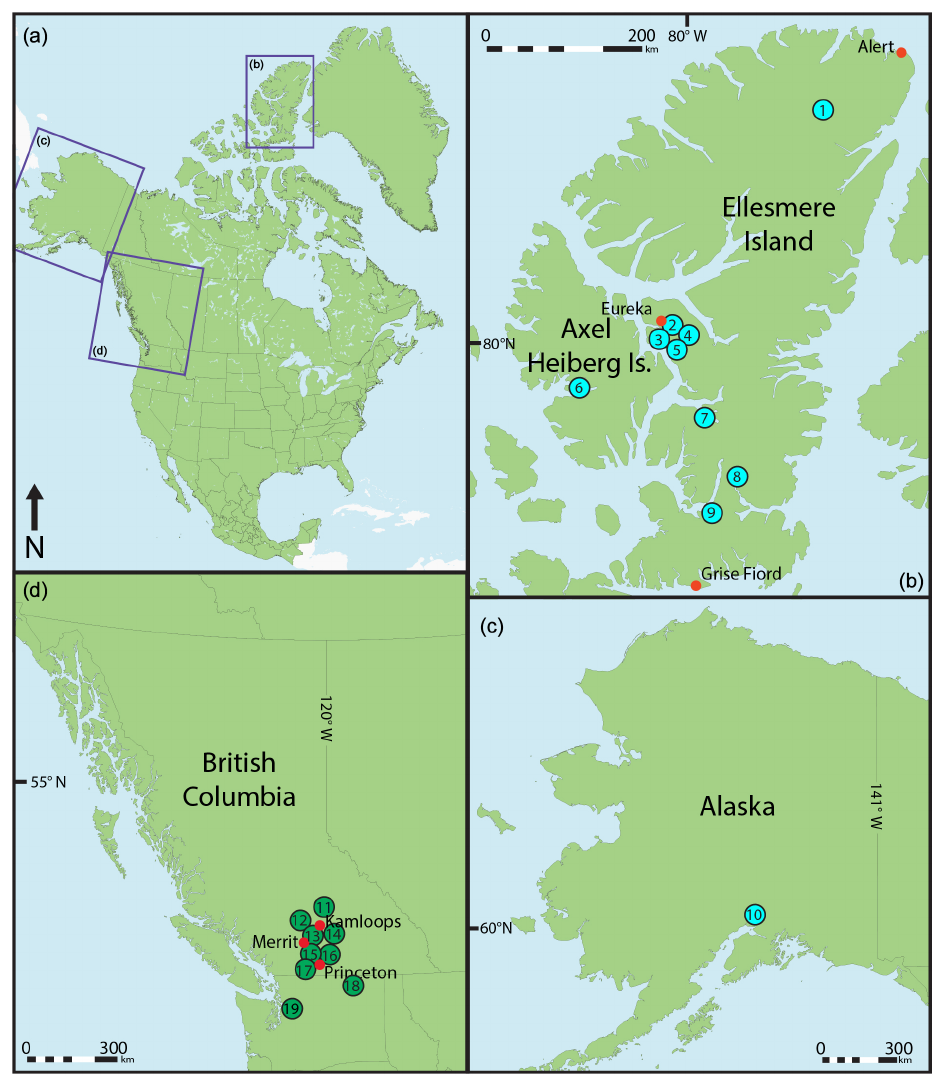
Figure 1. Map showing the location of the fossil localities used in this study. (1) Lake Hazen, (2) Mosquito Creek, (3) Ox-Head Creek, (4) Hot Weather Creek, (5) Fosheim Anticline, (6) Strand Fiord), (7) Strathcona Fiord, (8) Split Lake, (9) Stenkul Fiord, (10) Evan Jones Mine, (11) Chu Chua, (12) McAbee, (13) Quilchena, (14) Falkland, (15) Thomas Ranch, (16) One Mile Creek, (17) Whipsaw Creek, (18) Republic, (19) Racehorse